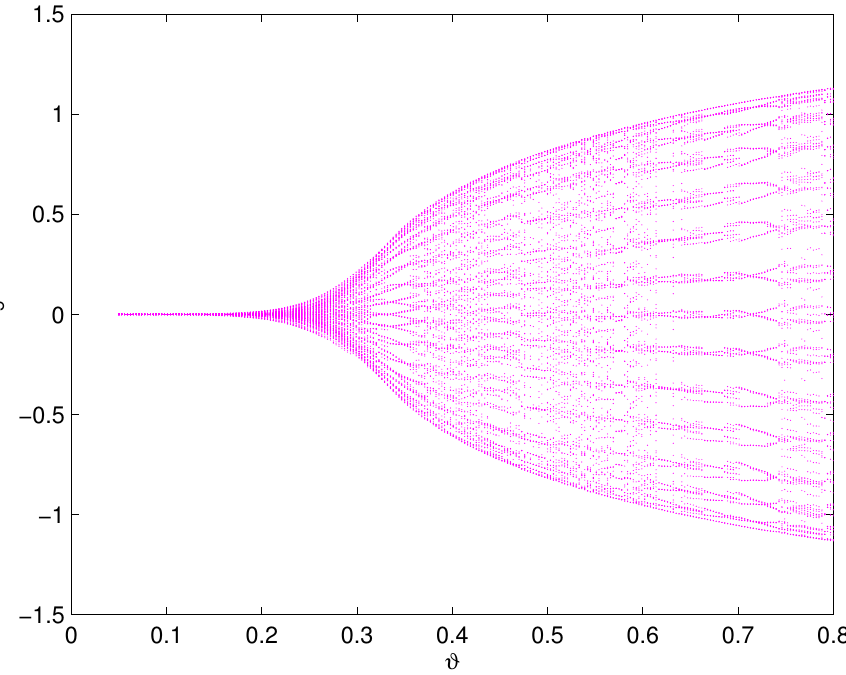
Figure 21. Bifurcation graph of system (73): the time delay ϑ versus the variable w 5 . The bifurcation number is